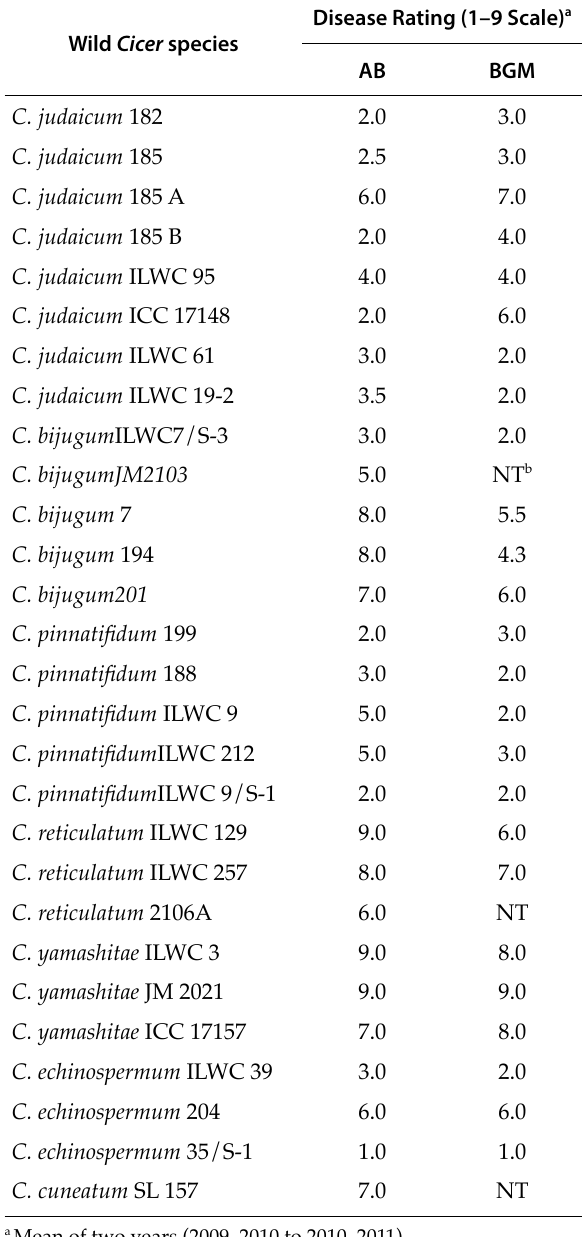
Table 2. Disease response of wild Cicer spp. to Ascochyta blight (AB) and Botrytis grey mould